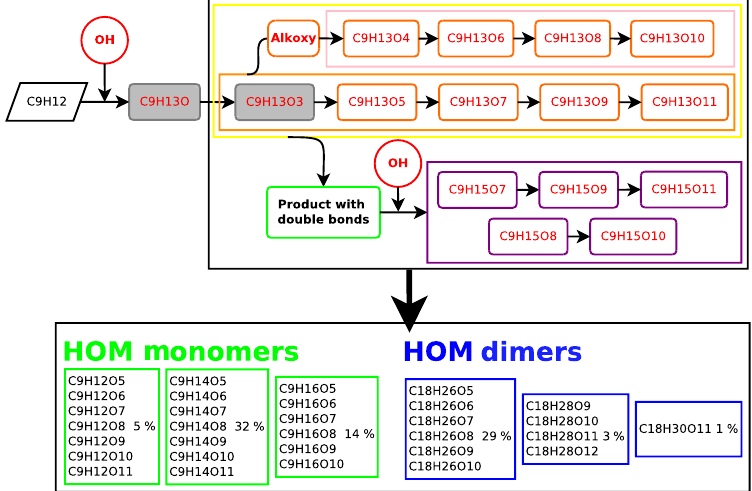
Figure 5. Proposed generalized reaction scheme of HOM formation for mesitylene (1,3,5-trimethylbenzene) after OH addition. Closed-shell species are displayed in black (even number of H), radicals (odd number of H) in red. Grey color denotes radicals that were not detected by the chemical ionization atmospheric pressure interface time of flight mass spectrometer. Radicals in the orange box are from the propagation of the initial OH attack with an odd number of oxygen atoms, radicals in the pink box are formed via an alkoxy intermediate step with an even number of oxygen atoms, and radicals in the purple box are products of a second OH addition. Reacting oxygen molecules along the radical propagation chain are not indicated. Closed-shell species are divided into monomers (green boxes) and dimers (blue boxes). The percentages in the boxes indicate the relative intensity of a peak to the total detected ArHC HOM signal. The sum does not add up to 100% because some peaks mainly coming from fragmentation are not included in the